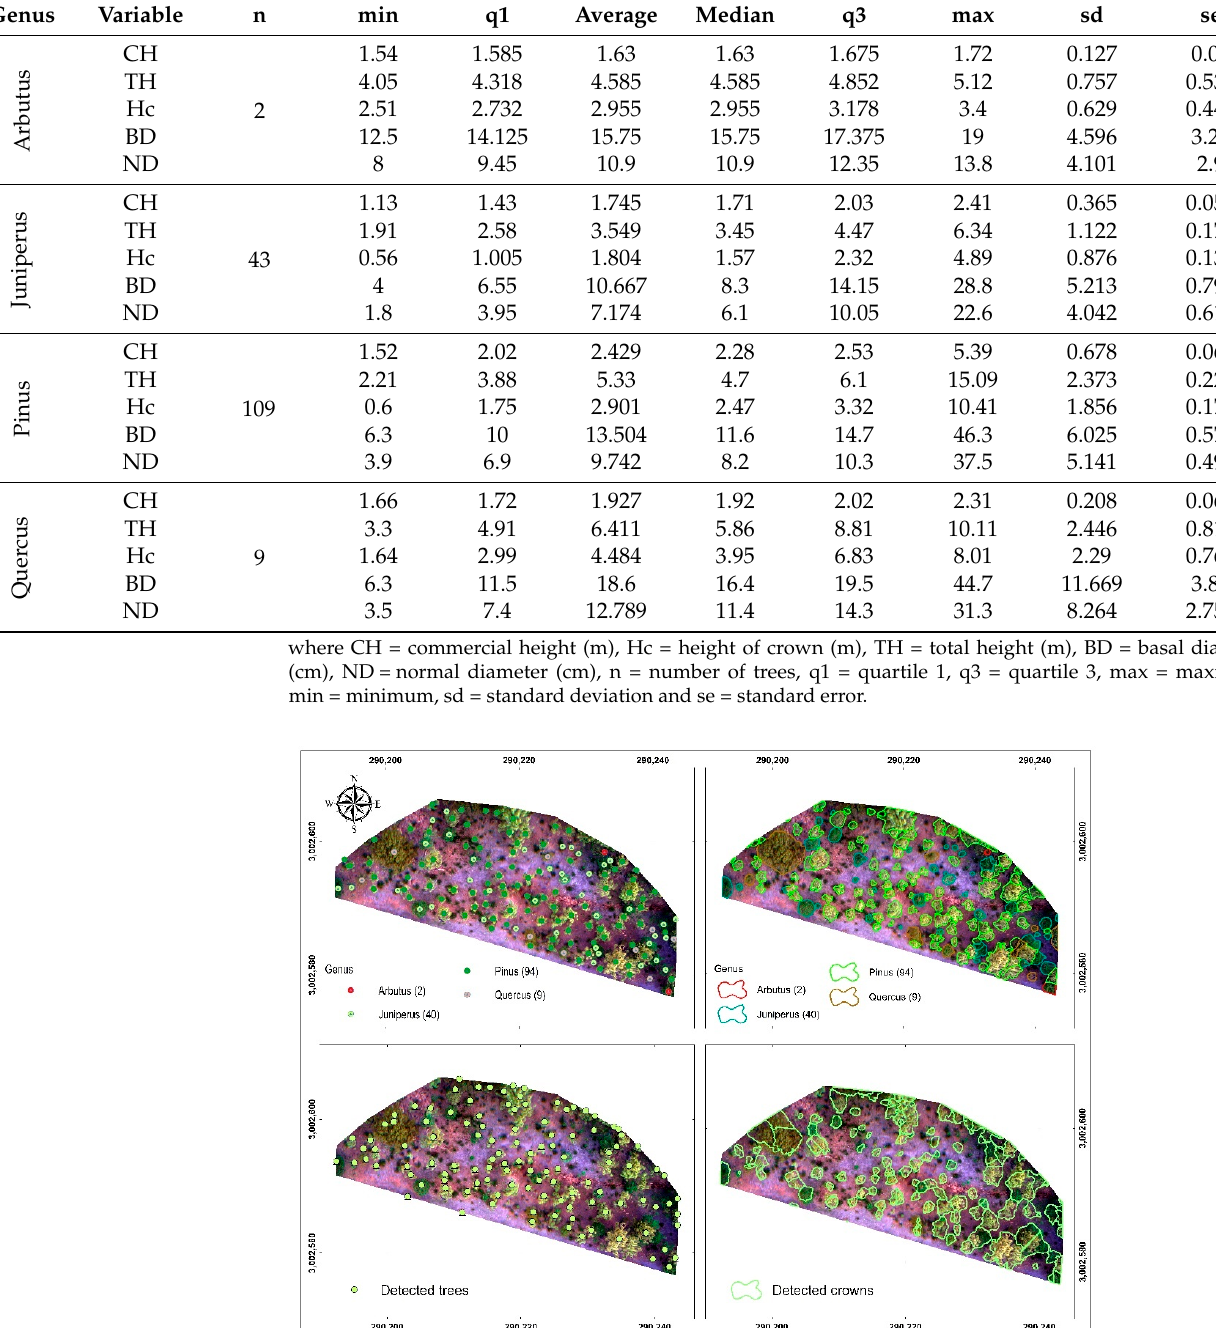
Figure 5. Regression analysis ( top ) and graph of residual vs. predicted values ( bottom ) for height ( left ) and crown delineation ( right ), at individual tree level with field data and estimates derived from the UAV, from 57 trees detected with the ForestTools algorithm. Three crowns were randomly selected (one of each genus) in order to obtain the mul- tispectral reflectance (Figure 6).